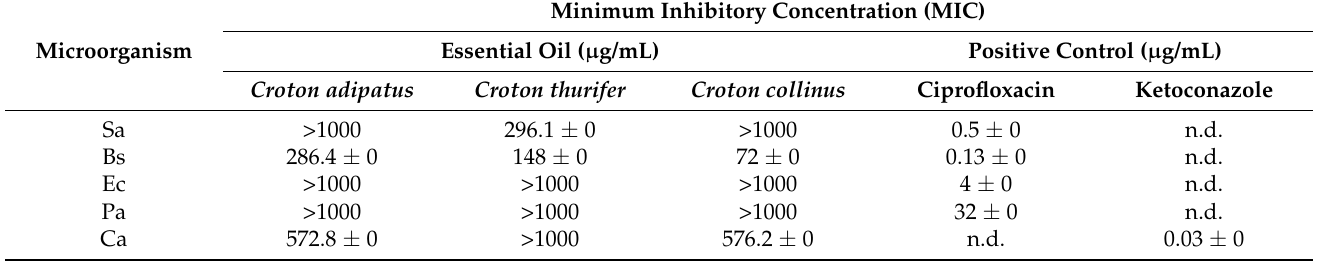
Table 3. Comparative table of the minimum inhibitory concentration (MIC) of the essential oils and standards by the colorimetric microdilution method. Minimum Inhibitory Concentration Microorganism